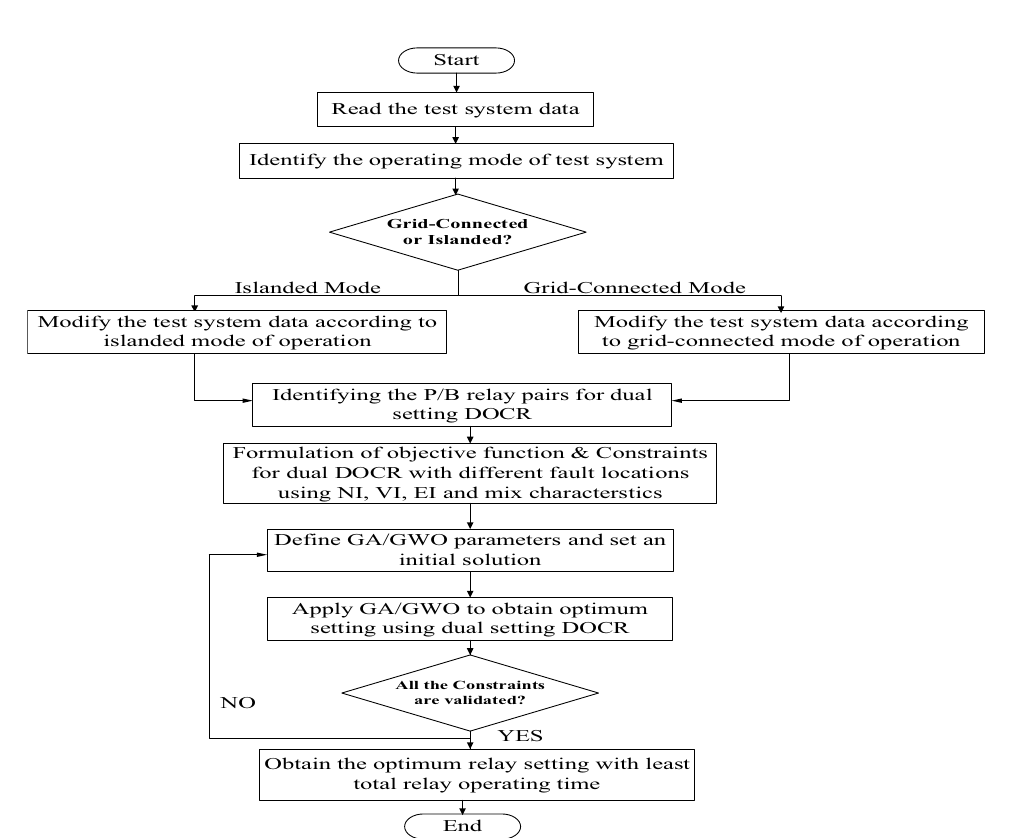
Fig. 3 Proposed protection method to determine optimal relay setting in grid connected and islanded operating